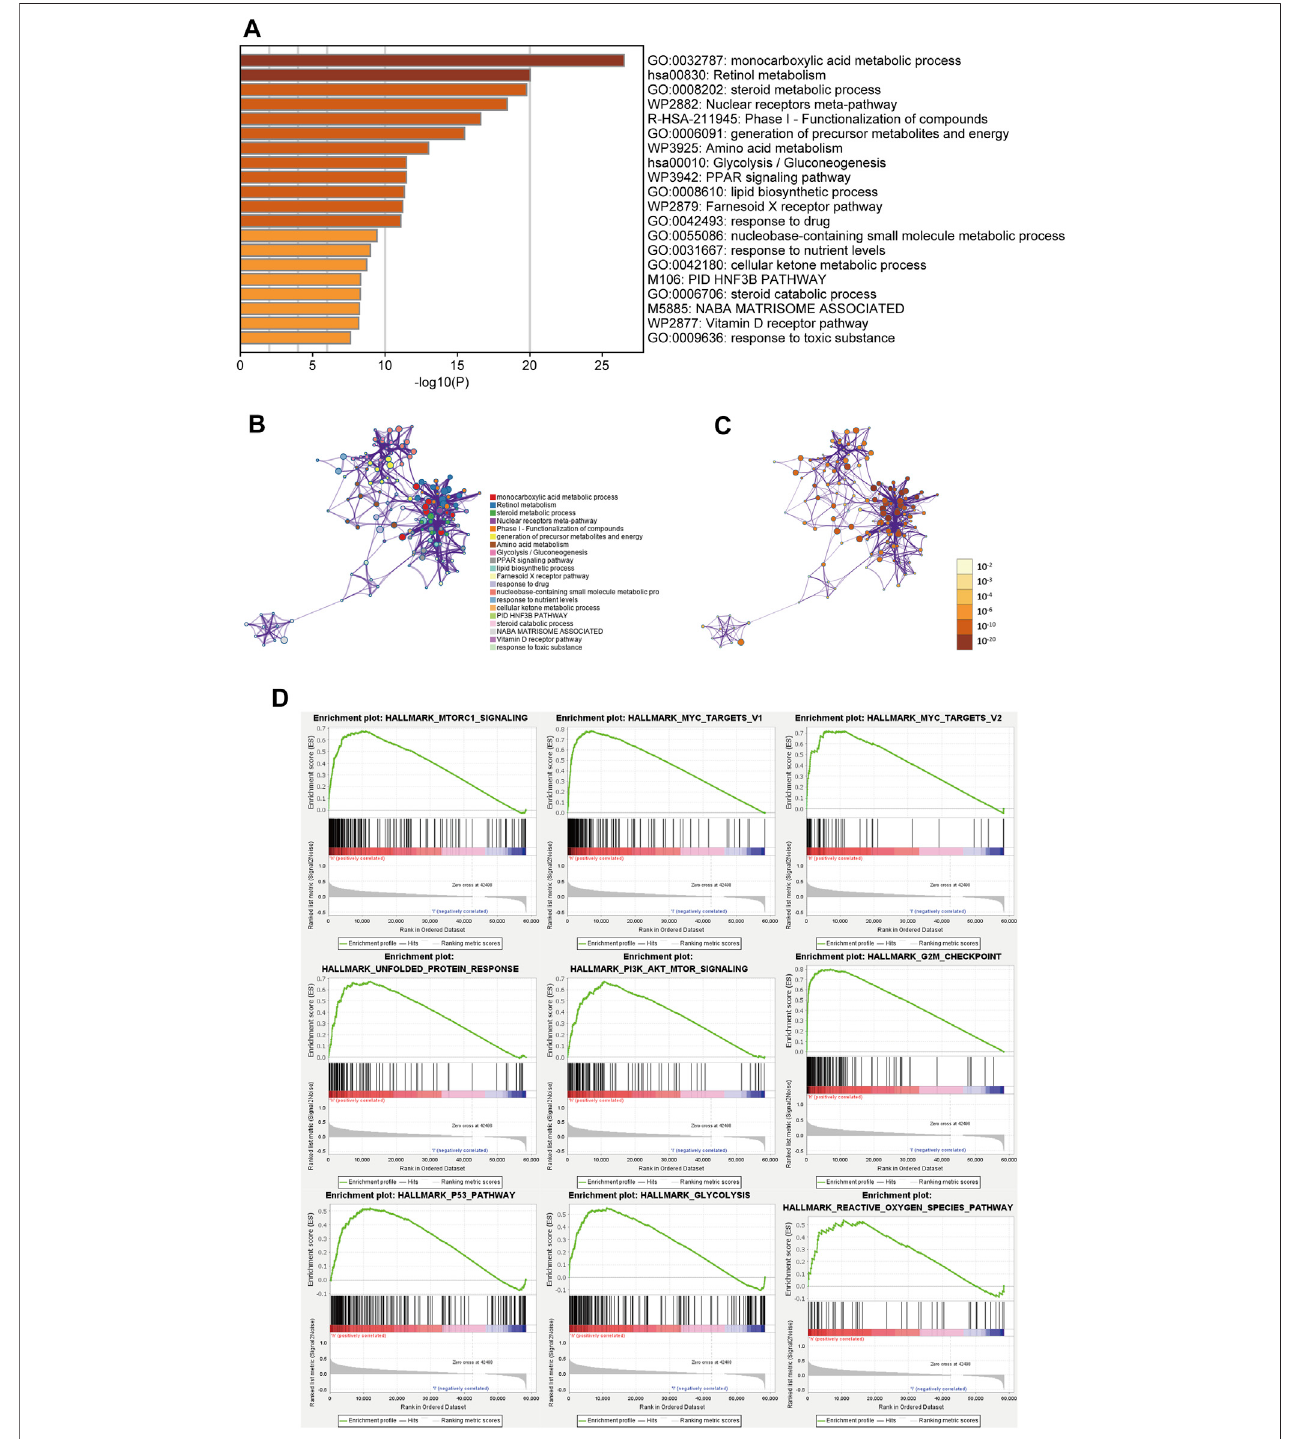
FIGURE7|(A) Heatmapofenriched termsacrosstheinputtedgenelist, coloredaccordingto p -value.Networkofenriched terms coloredaccording to (B) cluster ID (nodes with the same cluster ID are typically close to each other) and (C) p -value (terms with more genes tend to have higher p -values). (D) Gene set enrichment analysis (GSEA) indicating that tumor hallmarks were enriched in the high-FHPS group.